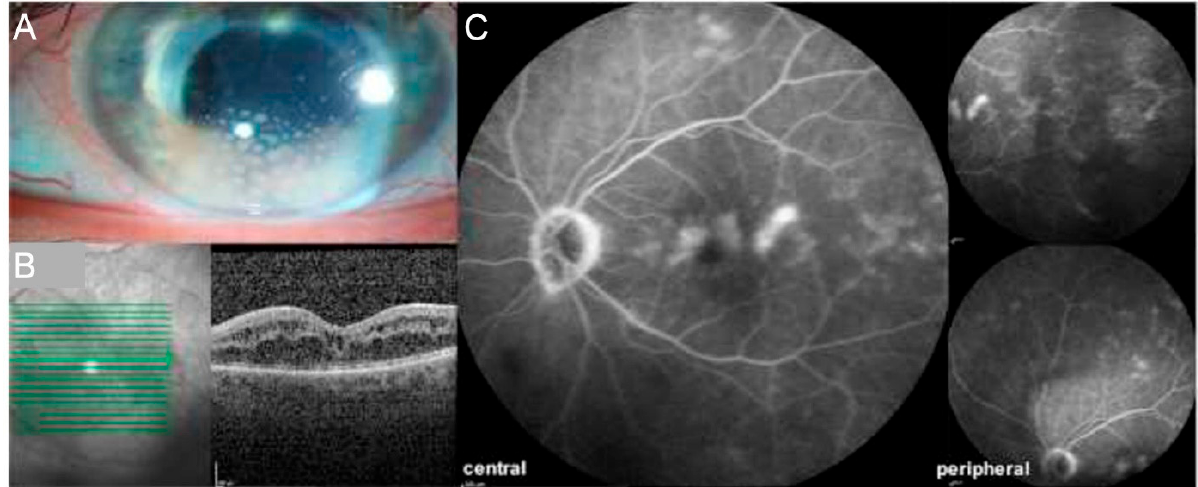
Figure 10. A 61-year-old woman with panuveitis associated with multiple sclerosis (MS) demon- strating granulomatous keratic precipitates on slit-lamp photography ( A ) and cystoid macular edema on optical coherence tomography (OCT) ( B ). Fluorescein angiography (FA) ( C ) depicts macular edema, optic disc leakage and vascular leakage of central and peripheral vessels. Furthermore, vitreous haze, indicated by a reduced visibility of the fundus best appreciated on peripheral FA and OCT images, is present.